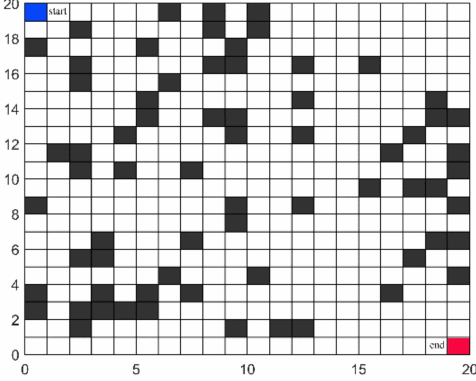
Figure 1. Grid map